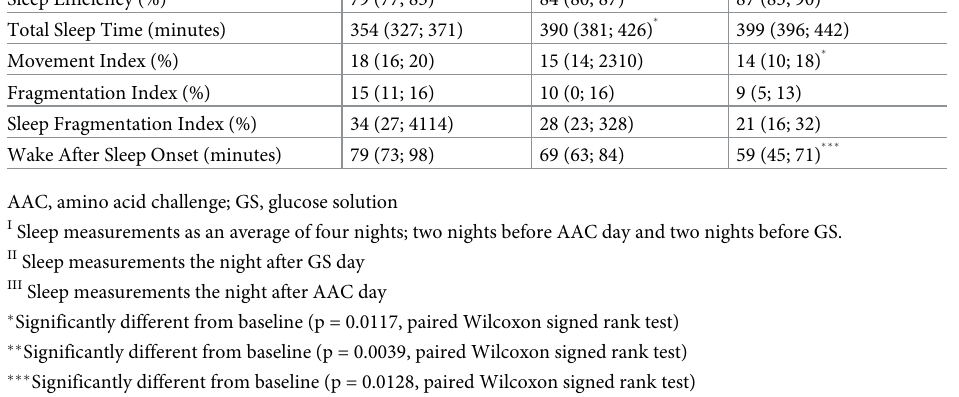
Table 3. The average sleep evaluation at baseline compared to the night after amino acid challenge (AAC) and the night after glucose solution (GS) measured by Actigraph. Median (25% quantile; 75% quantile) n = 9. Sleep Parameters